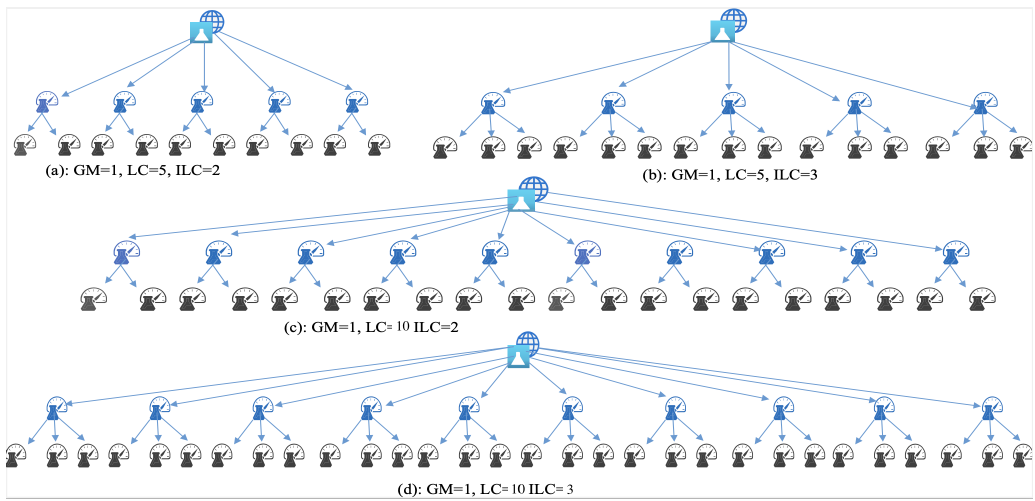
Figure 3. Network topologies for distributed federated learning of SHFL; the hierarchical architecture for multiple levels of LC and ILC is